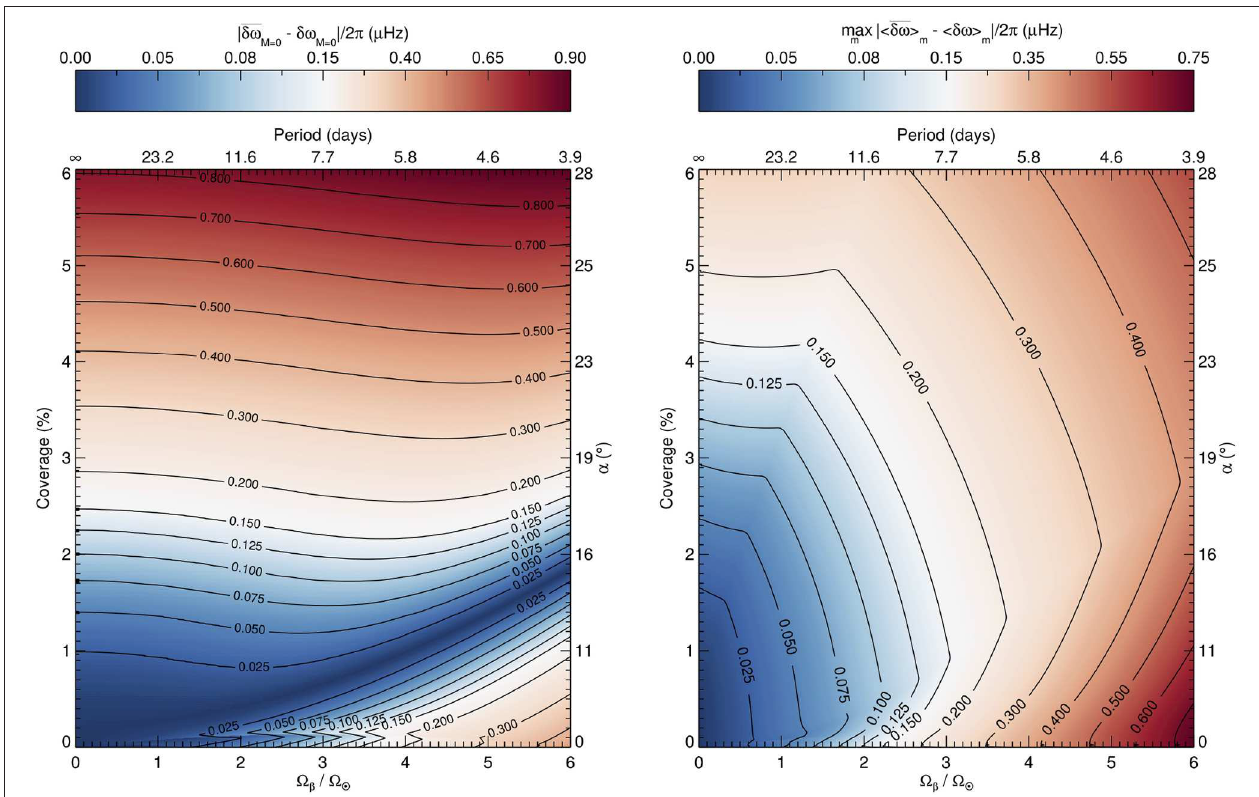
FIGURE 10 | (Left) Contour plot of the absolute difference | δω M = 0 − δω M = 0 | between the approximate shifts δω M = 0 (see Equation 62) and the first-order shifts δω M = 0 , as a function of stellar rotation rate and surface coverage of the active region. (Right) Contour plot of the maximum of the absolute difference |h δω i m − h δω i m | over all values of m , as a function of stellar rotation rate and surface coverage of the active